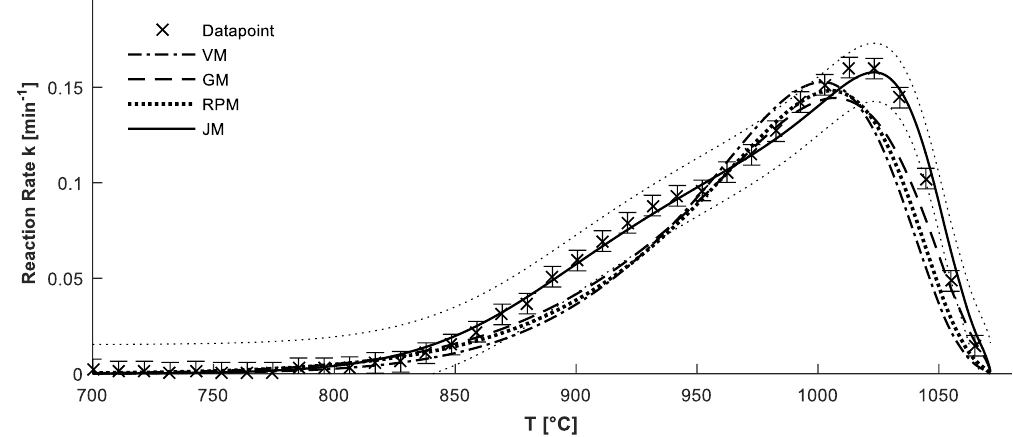
Figure 4. Measurement and L–H model results for steam gasification in configuration No. 2 (20 mL/min H₂O, 35 mL/min H₂); 95% confidence interval for JM is marked with a thin dotted line.